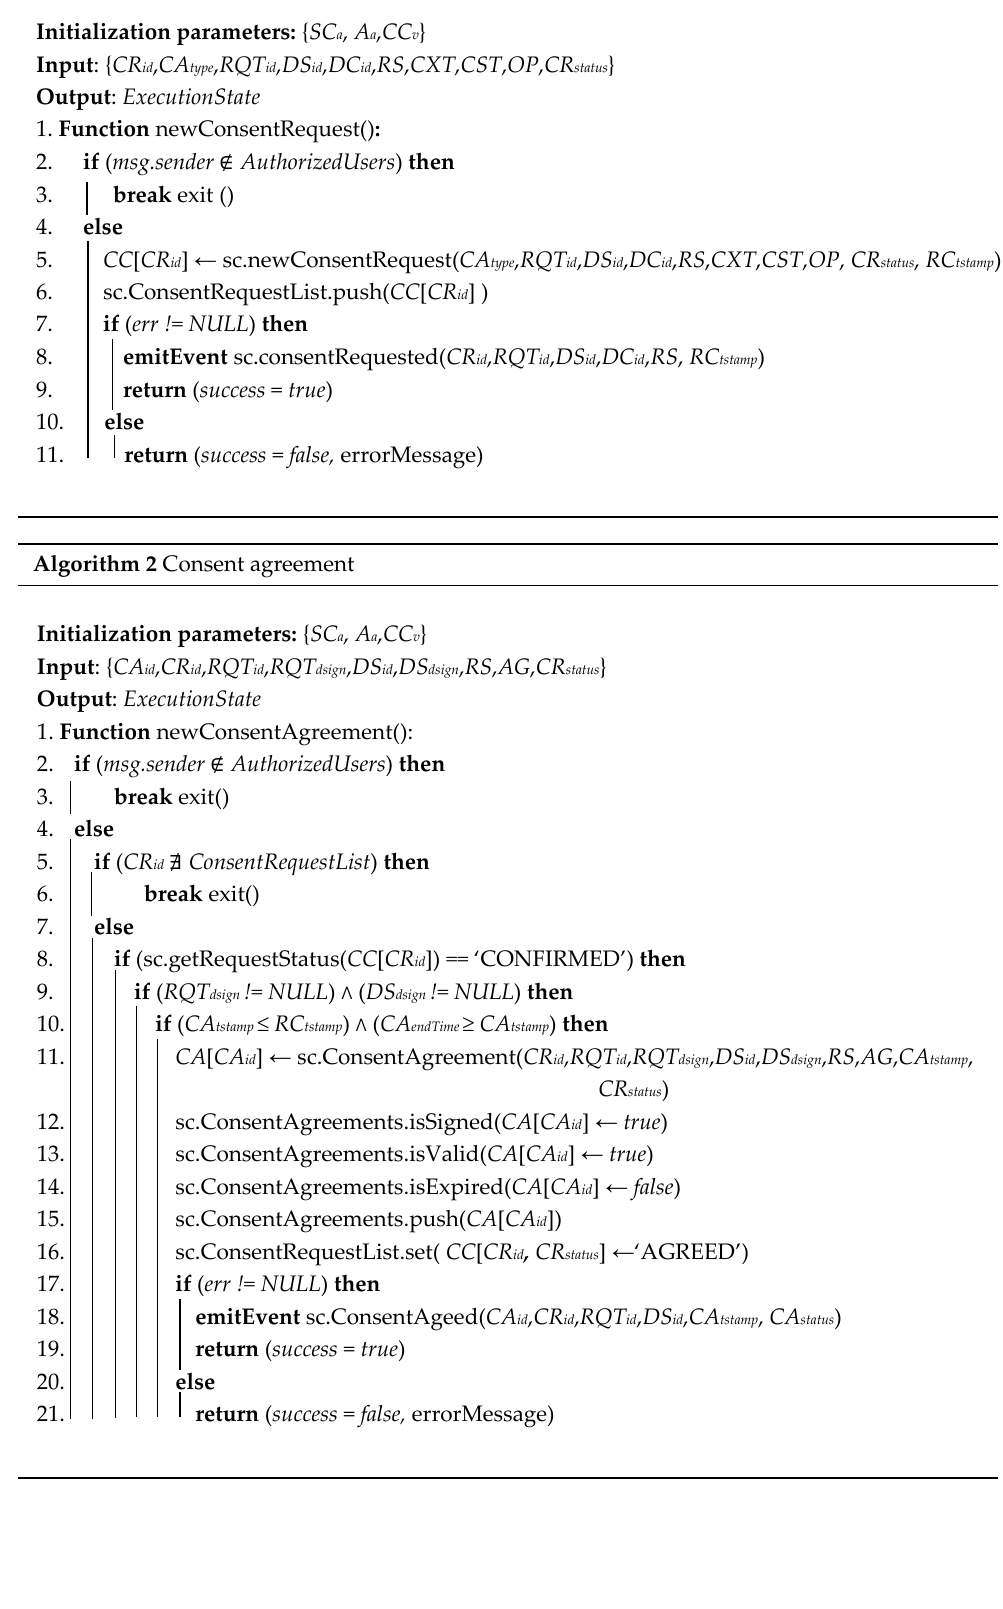
Figure 4 . Consent request and agreement between participating entities of the SC-DCMS. Algorithm 1: Consent agreement request